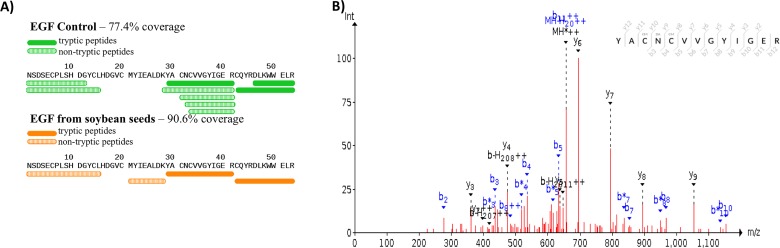
Mass spectroscopy data to detect the presence of EGF peptides in transgenic EGF soybean seeds.(A) Coverage of peptides detected in both commercially available EGF (green) and from transgenic soybean seeds (orange) using both trypsin (solid) and non-trypsin peptides (hatched). (B) Raw spectra data depicting the amino acid sequence CNCVVGYUGER detected from a low molecular weight enriched soluble dry seed protein extract from EGF transgenic soybean.